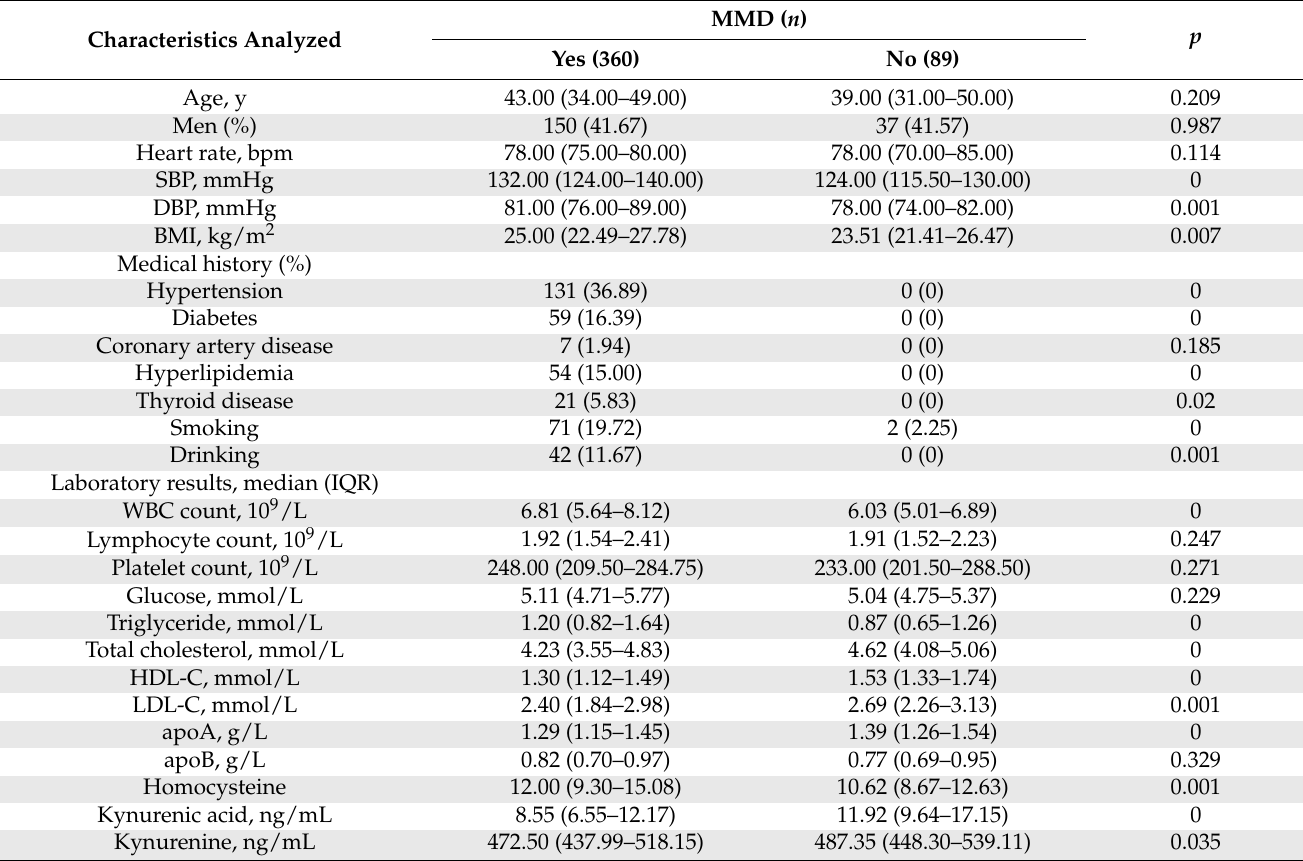
Table 1. Population characteristics among controls and MMD